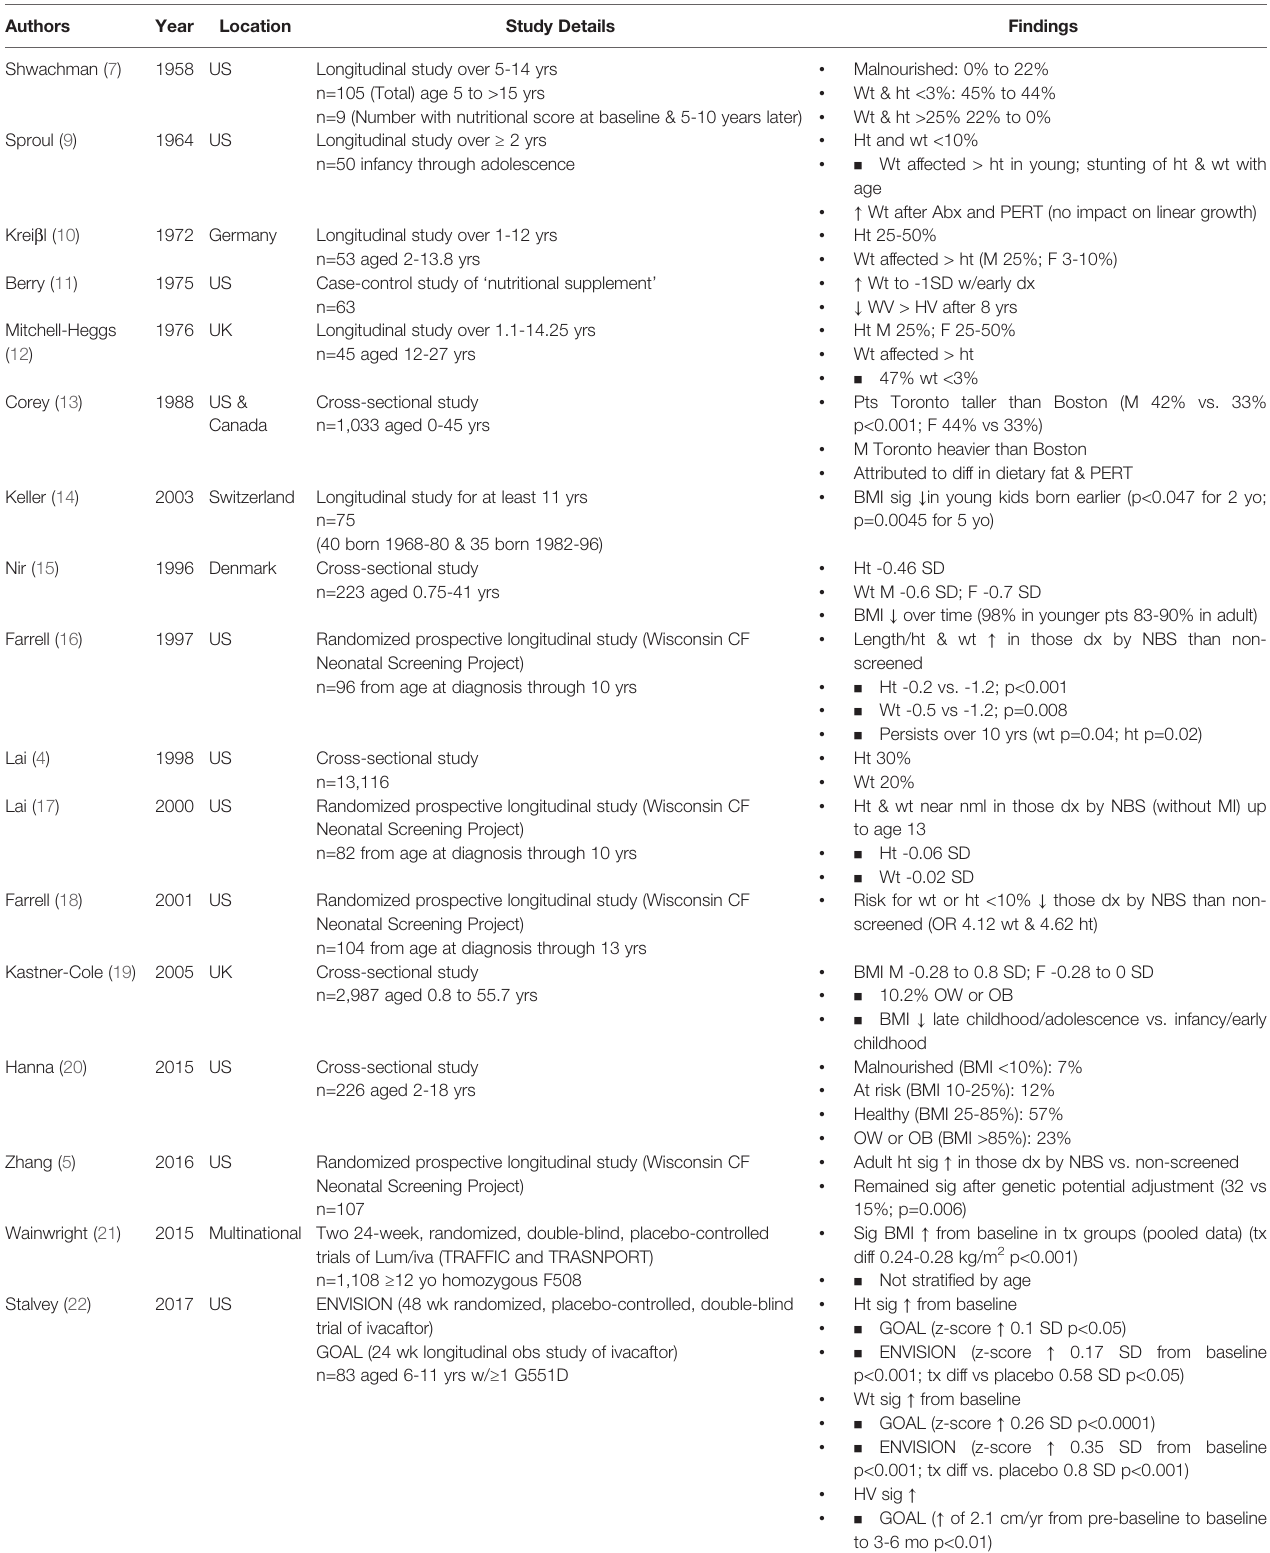
TABLE 1 | Growth Data over